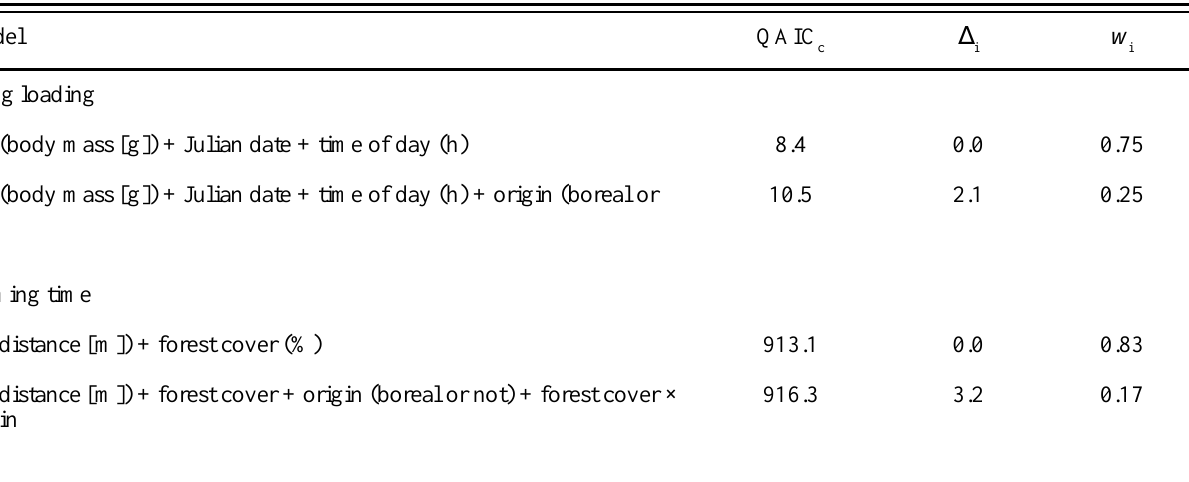
Table 2. Model selection assessing the influence of an Ovenbird’s origin on wing loading and homing time of translocated